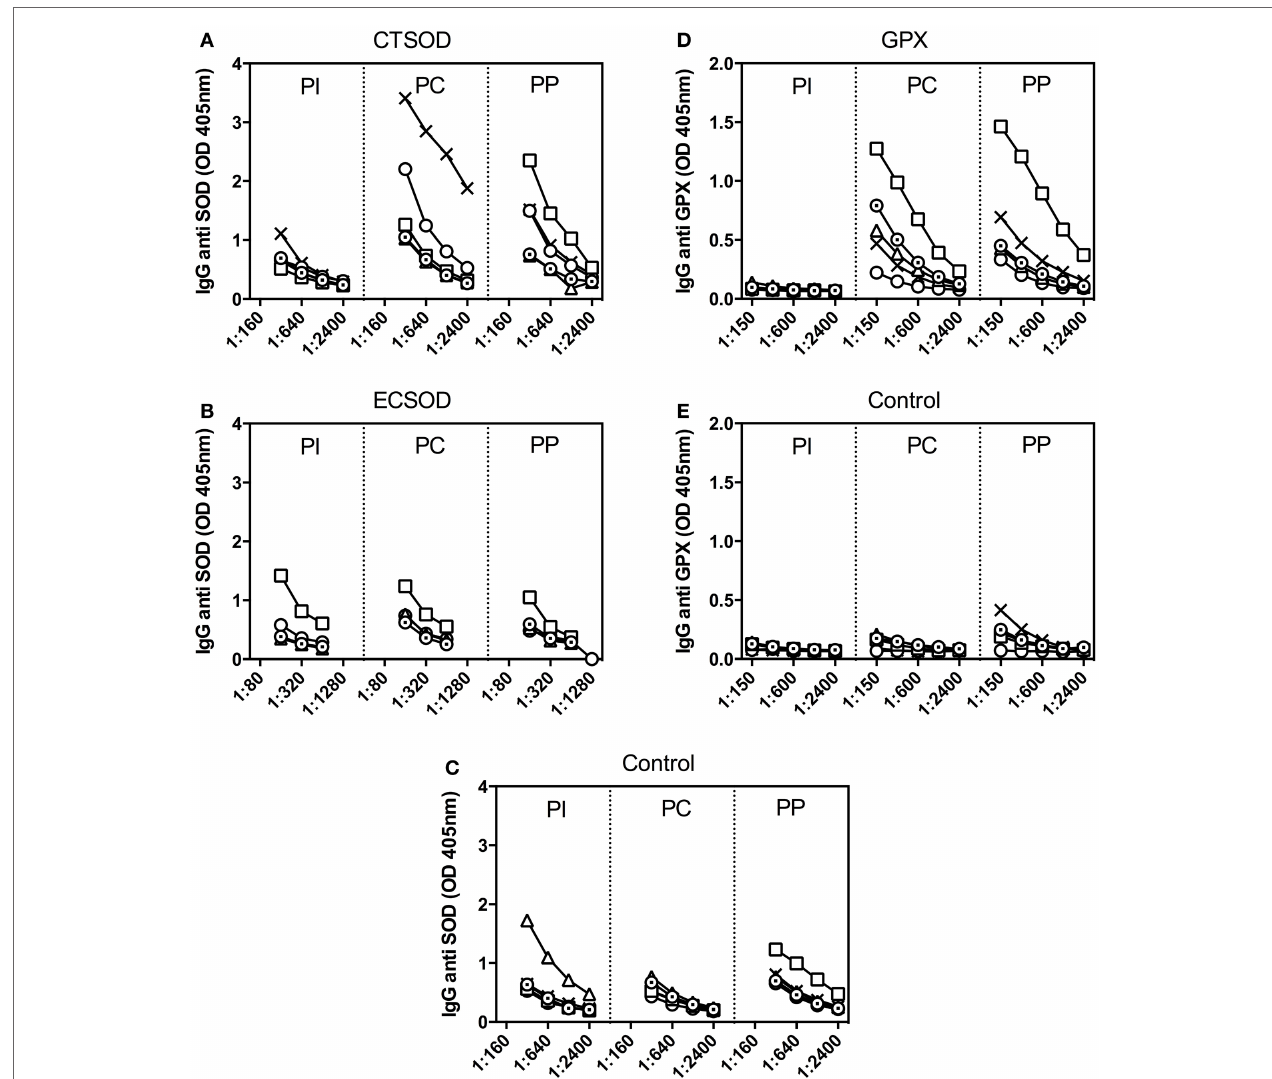
Figure 6 | antibody response from experiment 2 .Titration of baboon IgG antibodies against recombinant SOD (a–c) and GPX (D–e) from CTSOD (a) , ECSOD (B) , GPX (D) , and Control (c,e) groups ( n = 5 animals per group) before (PI), after immunizations (pre-challenge, PC), and before perfusion (pre-perfusion,